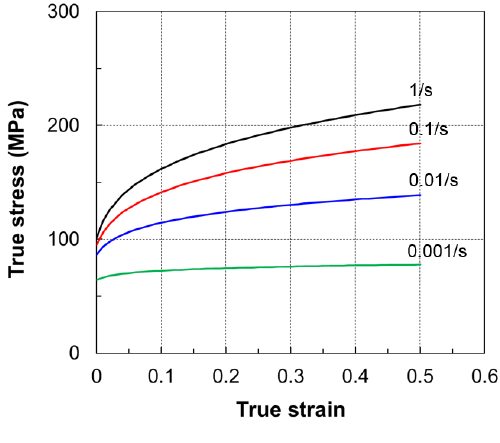
Figure 13. Effect of strain rate on the flow stress at 250 °C (with the specimen of 1.4 mm thickness).